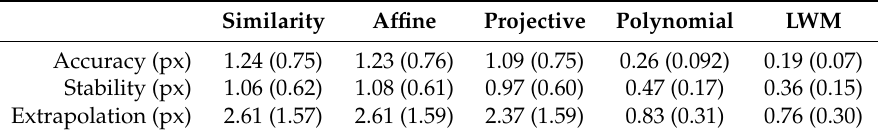
Table 1. Performance parameters (accuracy, stability, and extrapolation) of the five transformation model types assessing the suitability for the spatial referencing of wheat leaves. The accuracy is measured by the reprojection error of used reference points. The stability is measured by the reproduction error of unused control points within the leaf and the ability to extrapolate is measured by the root mean square error (RMSE) of unused control points at the base and the tip of the leaf. Displayed are the mean results during the whole time series of eleven days (standard deviation in